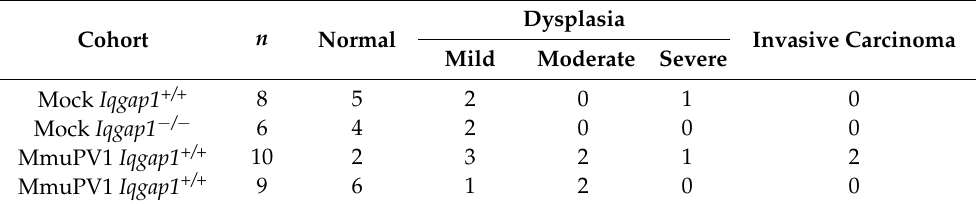
Table 1. Summary of disease severity in mock- or MmuPV1-infected Iqgap1 +/+ and Iqgap1 − / − mice. Cohort n Normal